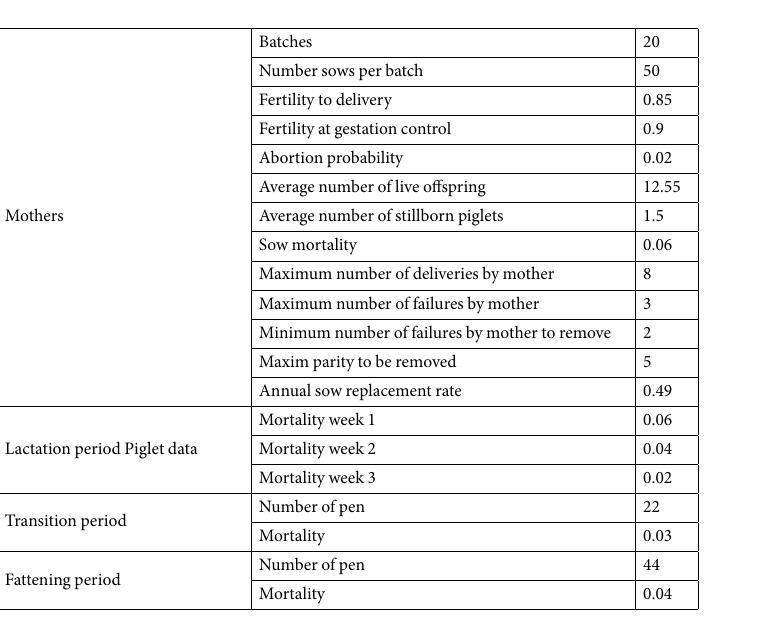
Table 5. Production parameters used to run the model in a 1000 sow